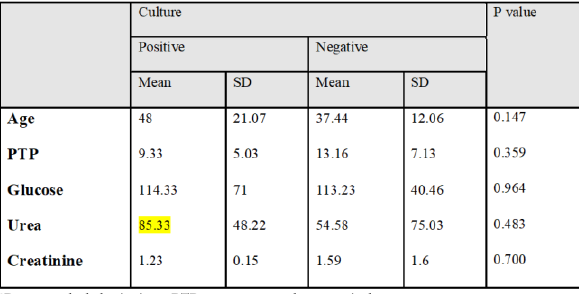
SD=stranded deviation, PTP=post-transplant period